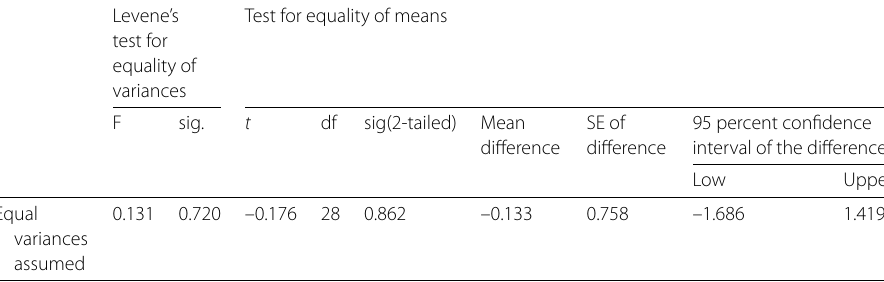
Table 2 Independent samples t -test for pre-test Levene’s test for